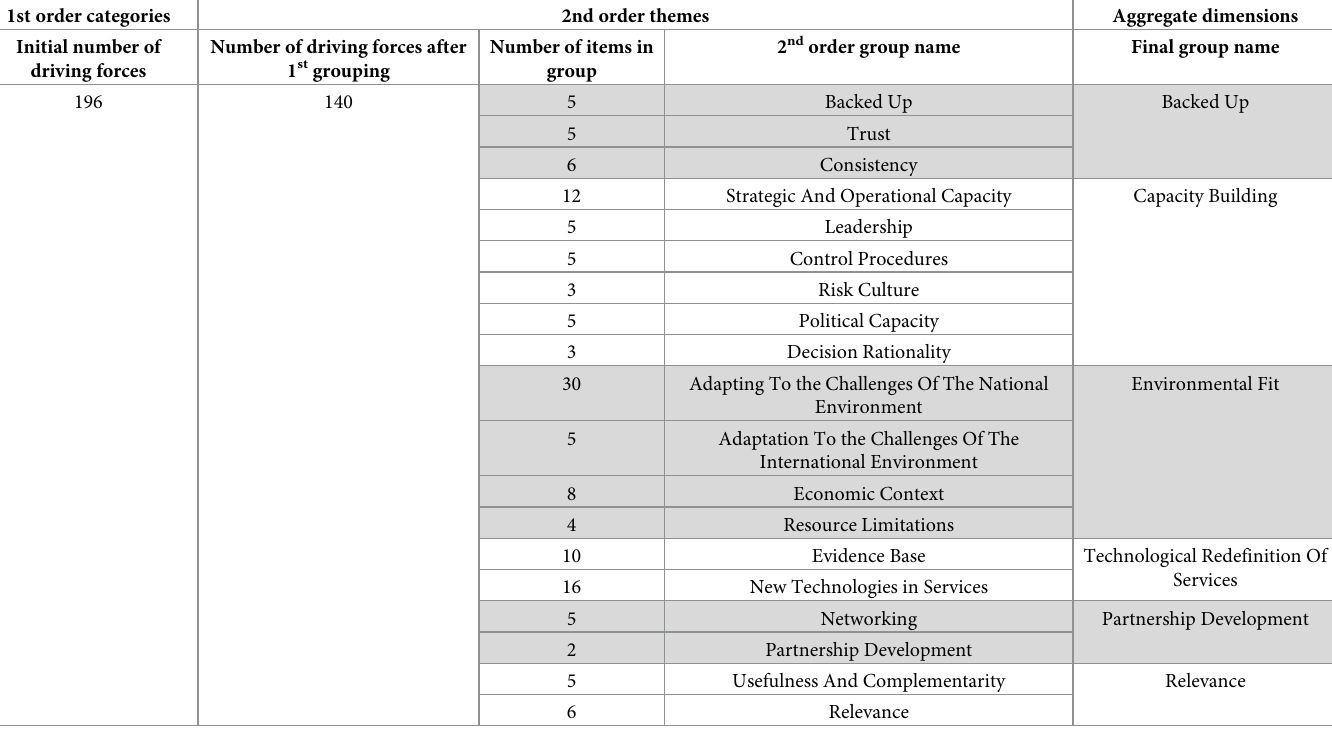
Table 3. Driving forces—Grouping process.